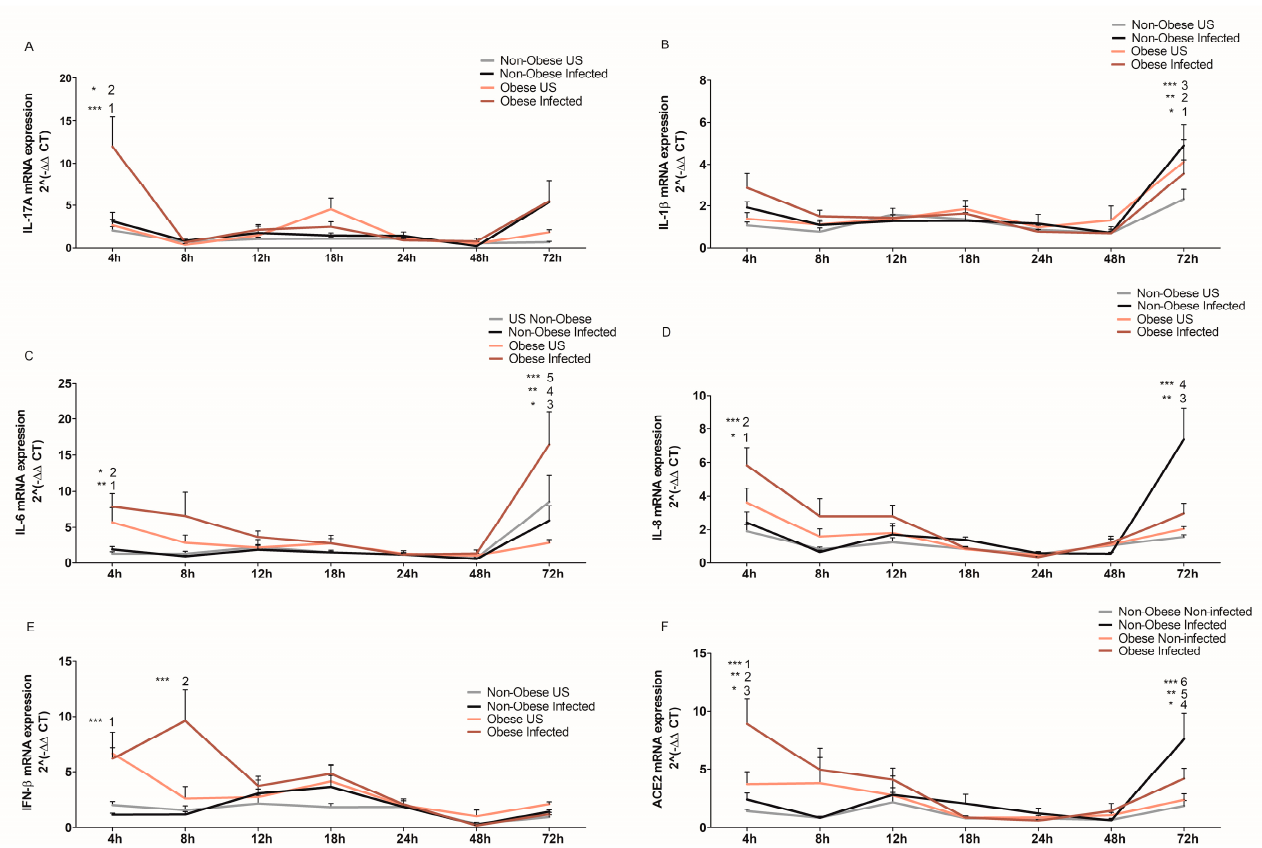
Figure 6. Inflammatory responses in SARS-CoV-2 infection of bronchial epithelial cells. mRNA expression of ( A ) IL-17A , (1) obese uninfected vs. obese infected at 4 h, non-obese infected vs. obese infected at 4 h, obese infected at 4 h vs. 8 h, obese infected at 4 h vs. 12 h, obese infected at 4 h vs. 18 h, obese infected at 4 h vs. 24 h, obese infected at 4 h vs. 48 h, (2) obese infected at 4 h vs. 72 h. ( B ) IL-1 β , (1) non-obese infected at 4 h vs. 72 h, non-obese infected at 18 h vs. 72 h, (2) non-obese infected at 12 h vs. 72 h, non-obese infected at 8 h vs. 72 h, non-obese infected at 24 h vs. 72 h, (3) non-obese infected at 48 h vs. 72 h. ( C ) IL-6 (1), non-obese infected vs. obese infected at 4 h (2) obese infected at 4 h vs. 48 h, (3) obese infected at 4 h vs. 72 h, (4) obese infected at 8 h vs. 72 h, non-obese infected at 72 h vs. obese infected 72 h, (5) obese infected at 12 h vs. 72 h. ( D ) IL-8 (1) obese infected at 4 h vs. 12 h, (2) non-obese infected vs. obese infected at 4 h, obese infected at 4 h vs. 18 h, obese infected at 4 h vs. 24, obese infected at 4 h vs. 48, (3) non-obese infected vs. obese infected at 72 h, (4) non-obese uninfected vs. non-obese infected at 72 h, non-obese infected at 4 h vs. 72 h, non-obese infected at 8 h, 12 h, 18 h, 24 h, 48 h vs. 72 h. ( E ) IFN- β , (1) non-obese infected vs. obese infected at 4 h, (2) non-obese infected vs. obese infected. ( F ) ACE2 , (1) obese non-infected vs. obese infected at 4 h, non-obese infected vs. obese infected at 4 h, obese infected at 4 h vs. 48 h, obese infected at 4 h vs. 12 h, obese infected at 4 h vs. 18 h, (2) non-obese infected at 4 h vs. 72 h, (3) obese infected at 4 h vs. obese infected at 12 h, (4) non-obese infected at 18 h vs. non-obese infected 72 h, (5) non-obese infected at 24 h vs. 72 h, non-obese infected at 48 h vs. 72 h, non-obese uninfected at 72 h vs. non-obese infected at 72 h, (6) non-obese infected at 8 h vs. non-obese infected at 72 h. n = 4/group. One-way ANOVA test and Tukey post hoc, * p ≤ 0,05, ** p < 0.01, *** p < 0.001.